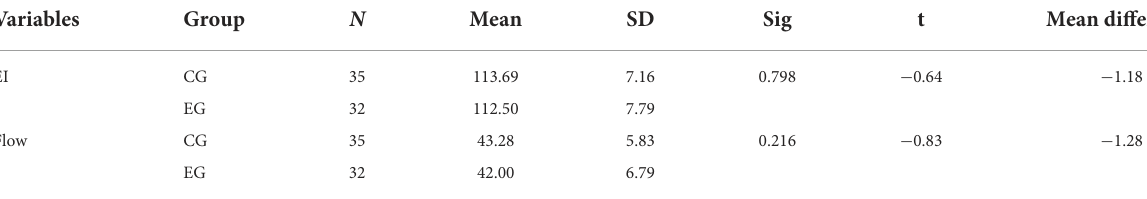
TABLE 1 Descriptive and inferential statistics on pretests.